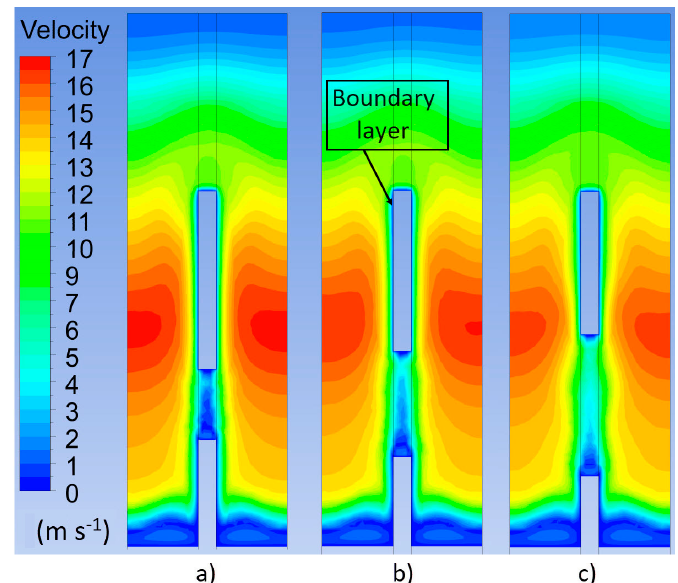
Figure 7. Velocity field in fin cross-section. The fins with hole ( a ) Ø2 mm, ( b ) Ø3 mm and ( c ) Ø4 mm.